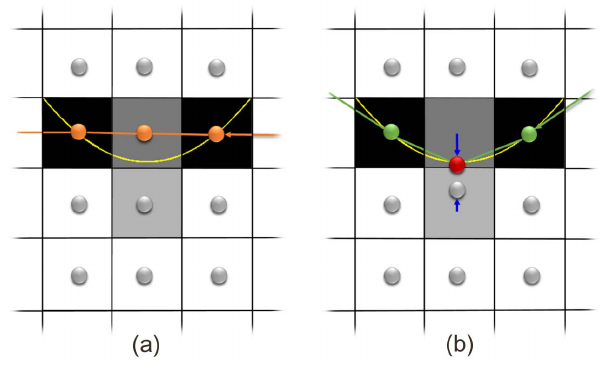
Figure 1. Graphs in Non-Euclidean space allow surface localization with subvoxel accuracy. (a) the graph in conventional Euclidean space allows graph search to find the lowest cost path (darkest voxel intensity) with voxel accuracy, compared to the yellow true surface; (b) the Non-Euclidean graph allows the green surface to be segmented through the lowest cost path with subvoxel accuracy, after the deformation field derived from the volume data (in this 2D example, derived from the 8-neighborhood) is applied to the two central nodes (blue arrows). Note the partial volume effect compared to their neighboring voxels, indicating that the actual center of low cost path is below the center of the upper dark voxel, as also indicated by the yellow true surface.